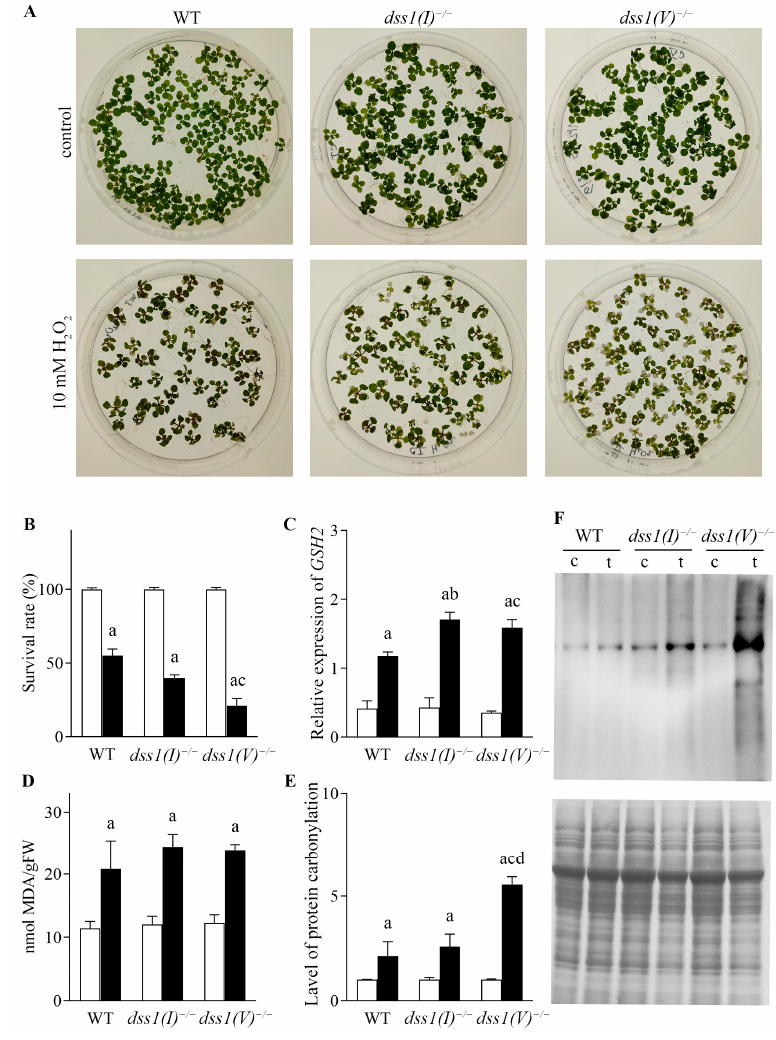
Figure 6. Effects of H 2 O 2 stress on WT and CRISPR/Cas9 dss1(I) − / − and dss1(V) − / − mutant seedlings. 14-day-old MS-grown WT and mutant seedlings were transferred to control MS medium containing 10 mM H 2 O 2 . ( A ) Seedlings were grown for three days under stress condition before the images were taken. ( B ) Survival rates of Arabidopsis WT and dss1(I) and dss1(V) mutant seedlings grown under 10 mM H 2 O 2 . ( C ) Relative expression of GSH2 . ( D ) Level of peroxidation (nmol/g FW) in WT and dss1(I) and dss1(V) mutant seedlings exposed to 10 mM H 2 O 2 for one day. ( E ) Level of protein carbotilation (total band densities were determined by ImageJ software v1.53n for densitometry). ( F ) Determination of protein carbonylation: OxyBlot- (top) and Coomassie-Brilliant Blue (CBB) stained SDS-PAGE (bottom) of control (c) or 10 mM H 2 O 2 -treated (t) Arabidopsis WT or dss1(I) and dss1(V) mutant seedlings. Data shown are representative of three experiments; relative band density is presented as the total band density of carbonylated proteins detected by anti-DNP antibodies/band density of total proteins stained with CBB. In histograms white bars show control (c) and black bars show 10 mM H 2 O 2 -treated (t) Arabidopsis WT or dss1(I) and dss1(V) mutant